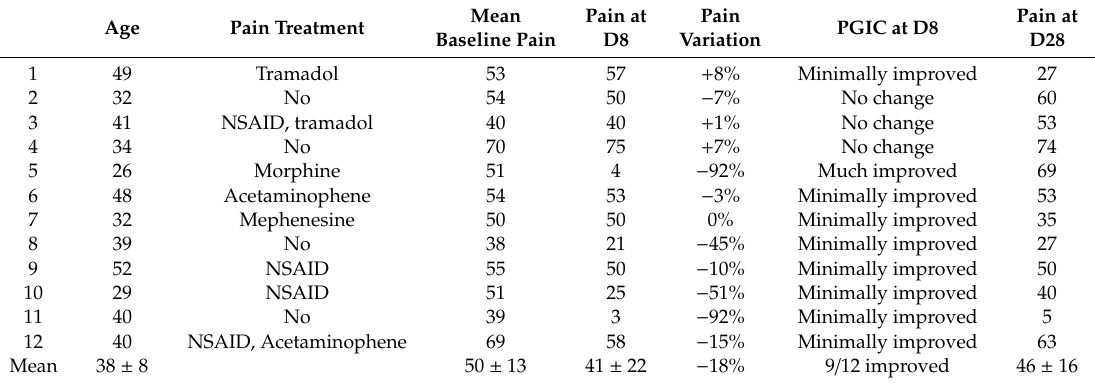
Table 1. Patients’ characteristics. Mean values are noted using bold characters.